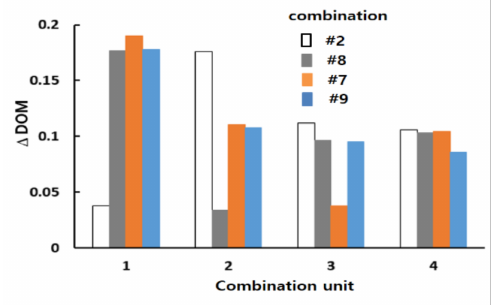
Figure 15. Comparison of the DOM increment in each combination unit for Re = 2.